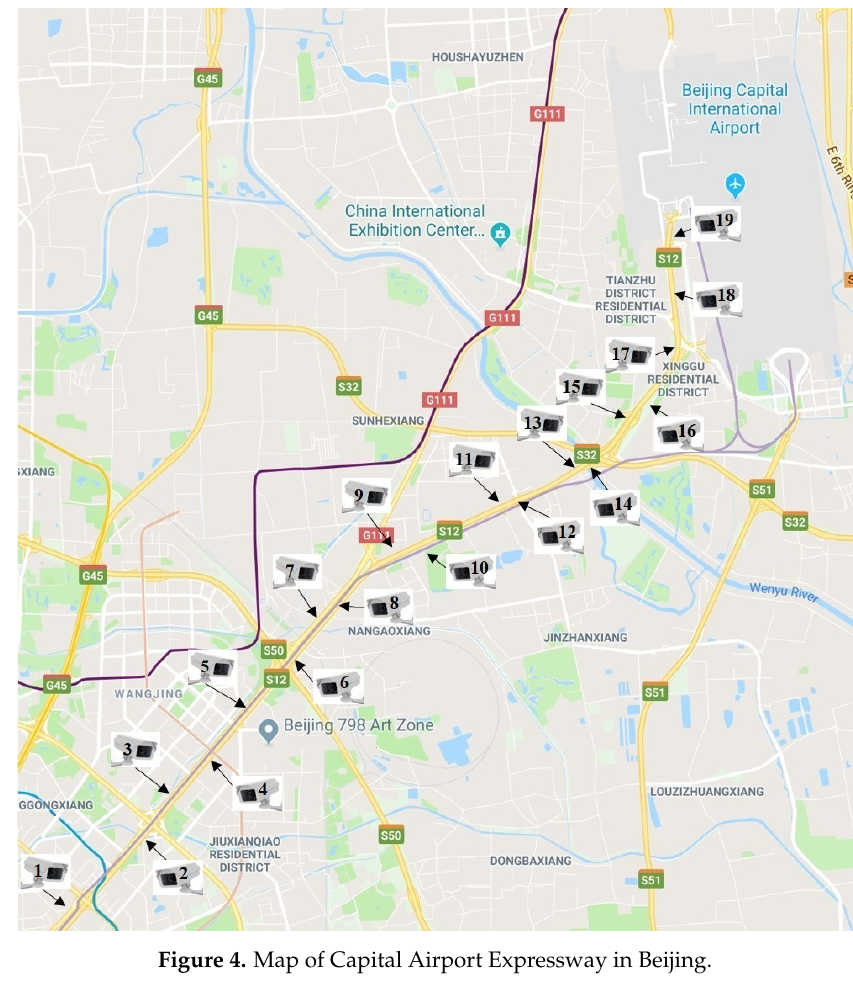
Figure 4. Map of Capital Airport Expressway in Beijing.